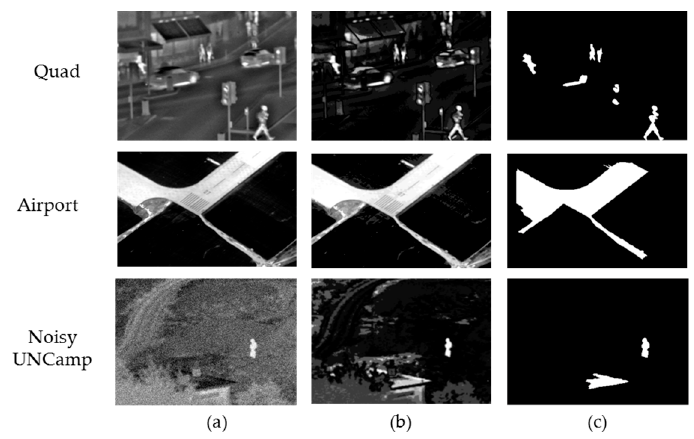
Figure 5. Region segmentation result based on region of interest (ROI): ( a ) infrared (IR) image; ( b ) Significance map of the IR image; ( c ) Region segmentation result based on ROI.